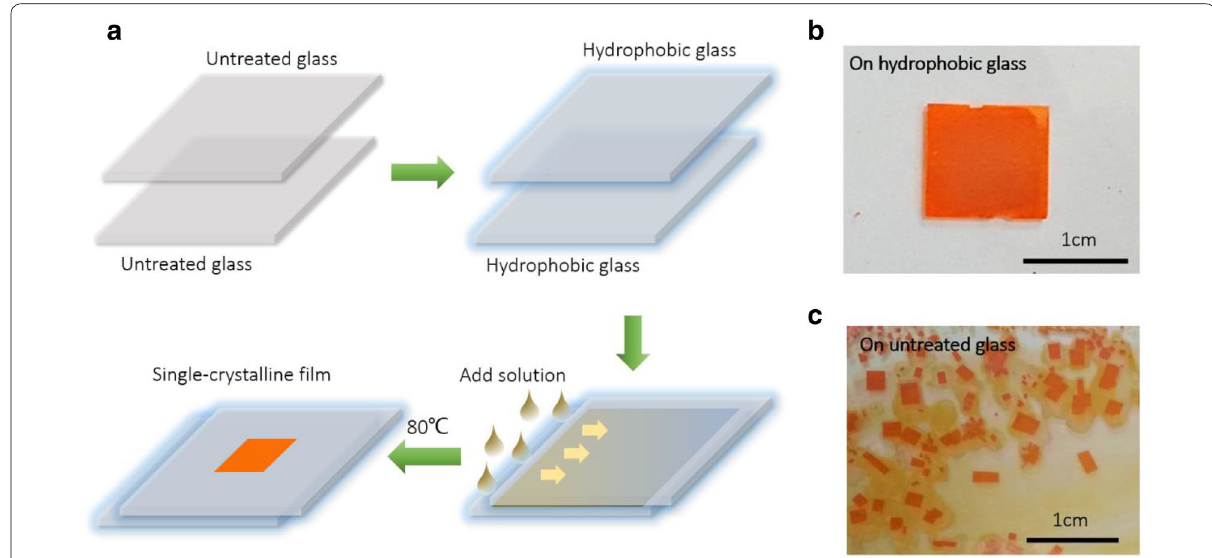
Fig. 1 Growth of perovskite SCTF. a Schematic diagram of the growth process. The surfaces of two glass substrates are treated to be hydrophobic and put face‑to‑face to create a confined space. We then keep a constant growth temperature of 80 °C and add the precursor into the gap continuously via capillarity effect to grow the SCTFs. b Photograph of a centimeter‑scale perovskite SCTF grown inside two hydrophobic substrates. c Millimeter‑scale single‑crystalline flakes grown inside two untreated